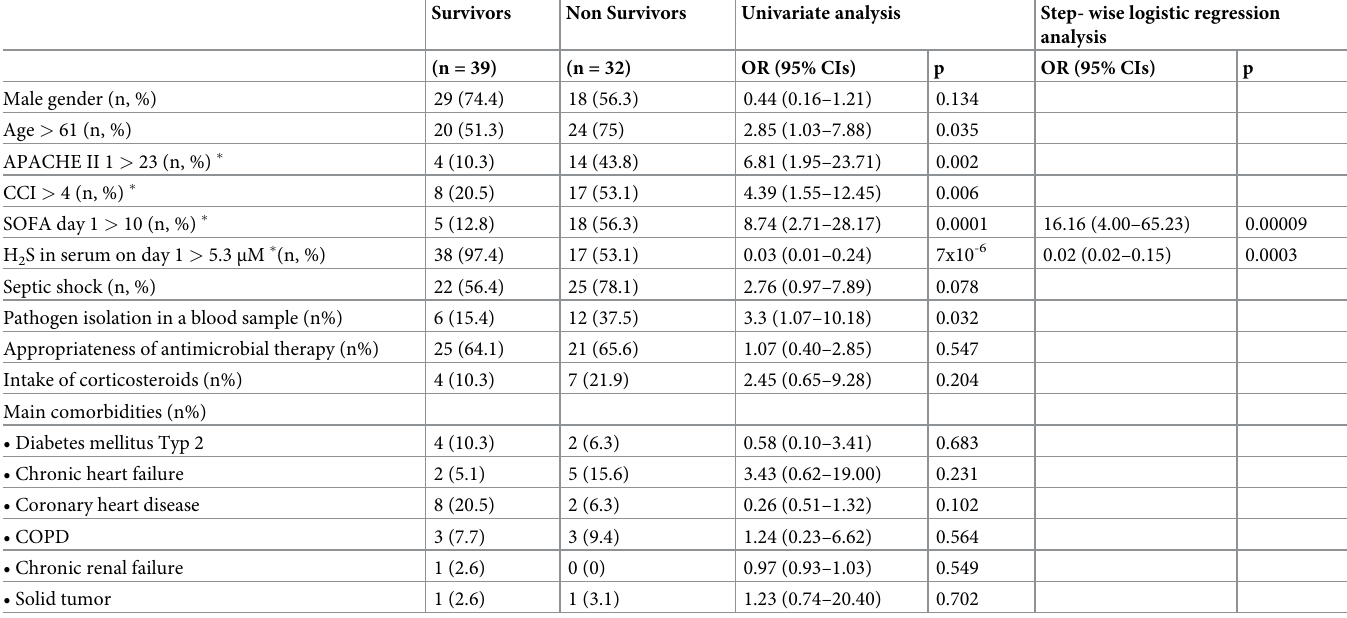
Table 1. Baseline and clinical characteristics of patients with sepsis due to P . aeruginosa associated VAP, univariate and step- wise forward logistic regression analy- sis of parameters associated with unfavorable outcome of sepsis due to VAP by P . aeruginosa . Survivors Non Survivors Univariate analysis Step- wise logistic regression